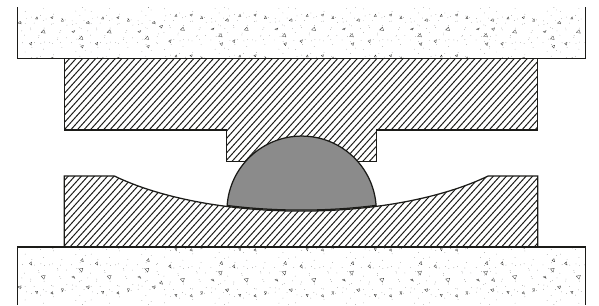
Figure 3: Schematic view of a single curved surface slider (CSS).